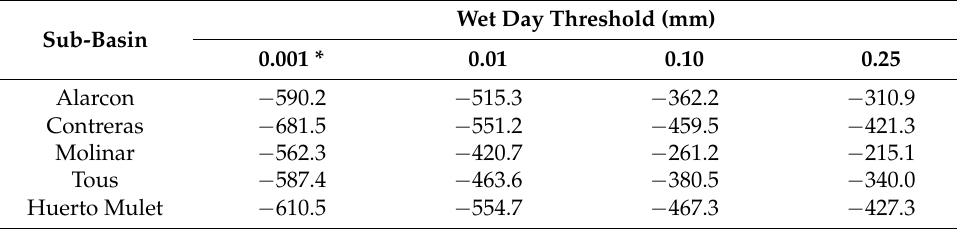
Figure 5. Fourier series (daily average) of maximum temperature series (66 years): ( a ) mean wet days, ( b ) mean dry days, ( c ) standard deviation wet days, and ( d ) standard deviation dry days. Table 1. AIC for different wet thresholds and stochastic occurrence